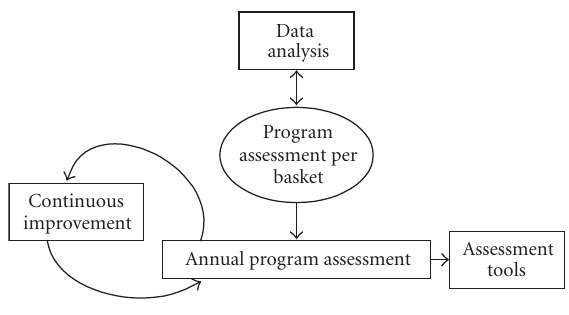
Figure 6: Program Assessment Cycle.